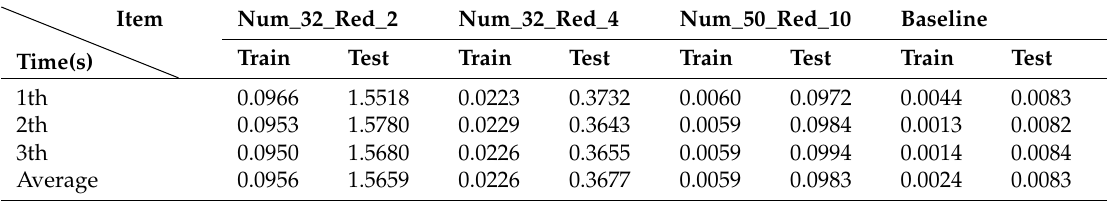
Table 3. Time efficiency comparison of DTW with sparse optimization algorithm (time unit